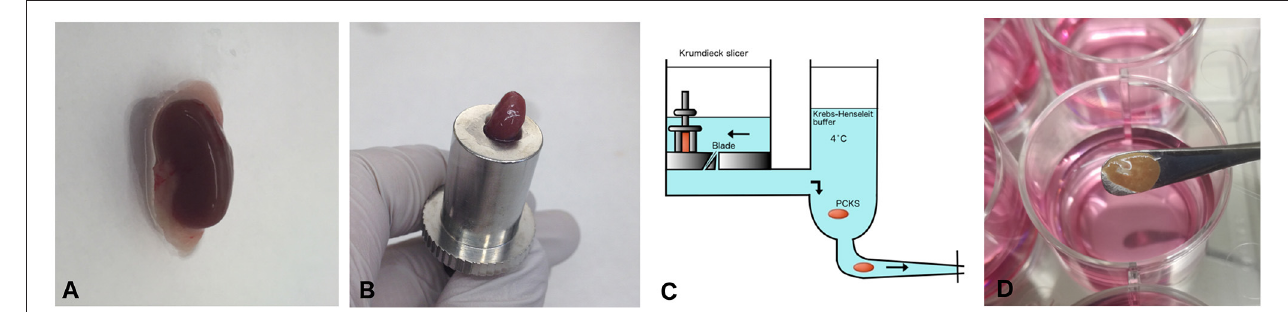
FIGURE 1 | Workflow preparation of mPCKS. (A) Murine kidneys are prepared by removing the adipose tissue. (B) The entire kidney is placed in the core holder. (C) Murine PCKS (250–300 µ m in thickness) are prepared with the Krumdieck slicer and subsequently kept in ice-cold University of Wisconsin (UW) solution. (D) Slices